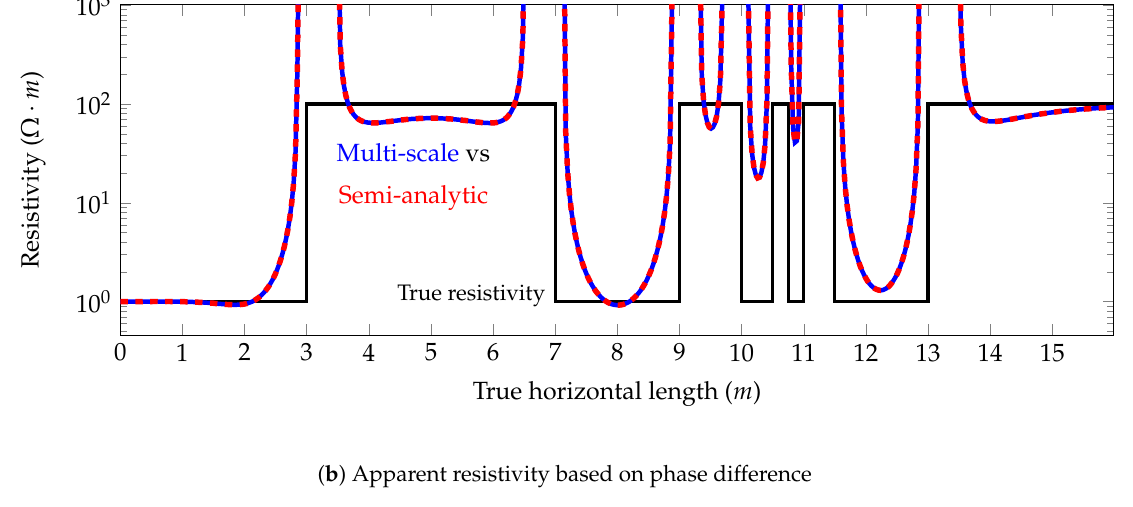
Figure 17. Model problem 2. Apparent resistivity for the zz coupling for a 89 ◦ deviated well.